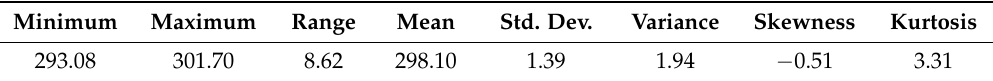
Table A4. Water outlet temperature distribution statistics [K]. Minimum Maximum Range Mean Std. Dev.